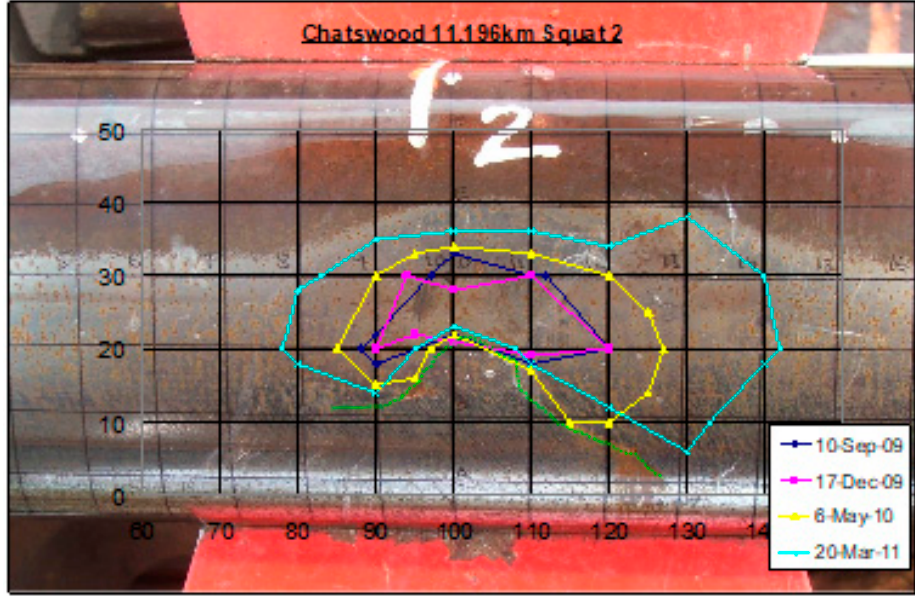
Figure 13. Rail squat growth.